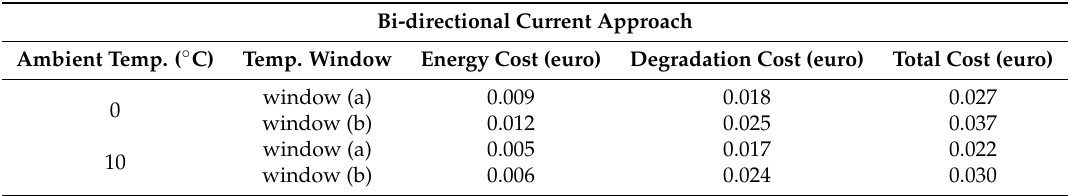
Table 5. Costs for 8 h preheat with bi-directional current pulses method for the NMC/G pouch cell